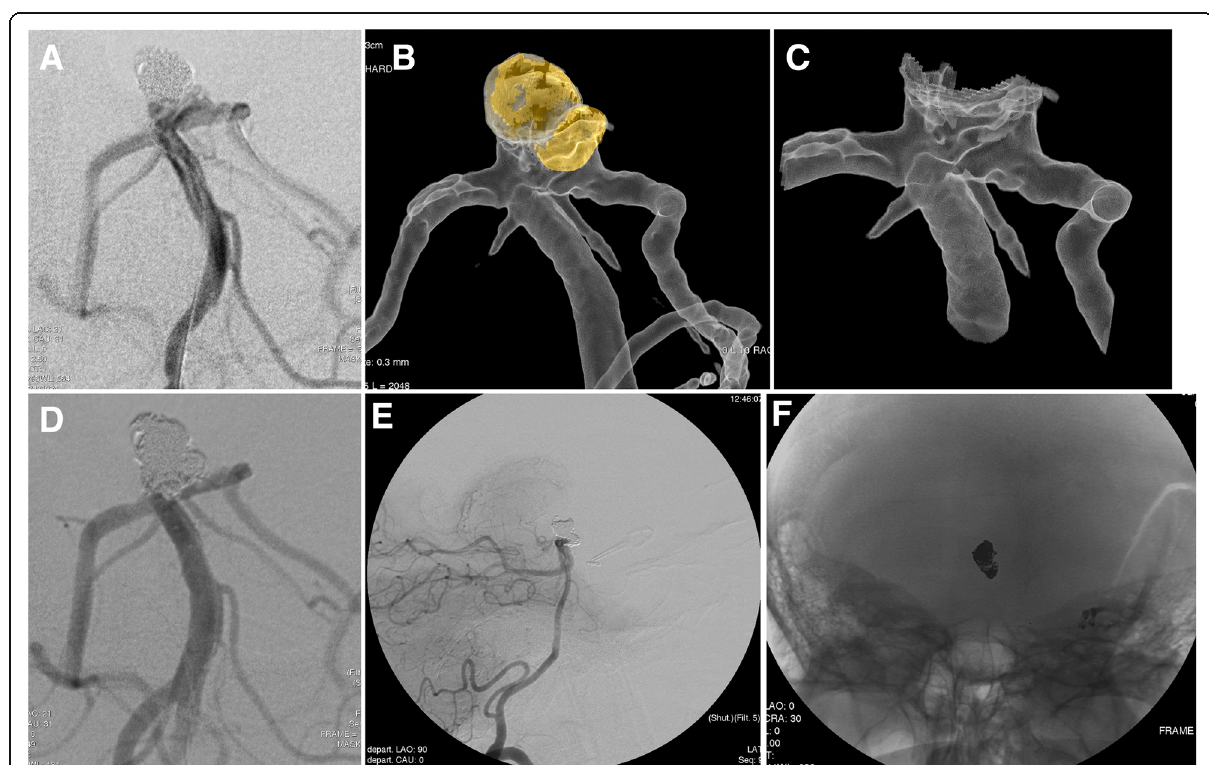
Fig. 1 Recanalization of basilar tip aneurysm. a DSA of the basilar artery showing recanalization at the aneurysm neck. b 3D DSA with dual- volume technique clearly differentiates the densities of the occlusion coil and the recanalized part of the aneurysm. c Dual 3D DSA clearly depicts the recanalized part. d DSA final control AP view showing total occlusion of the sac. e Lateral view subtracted DSA image shows total occlusion of the aneurysmal sac. f Post-embolization non-subtracted image shows the added coil